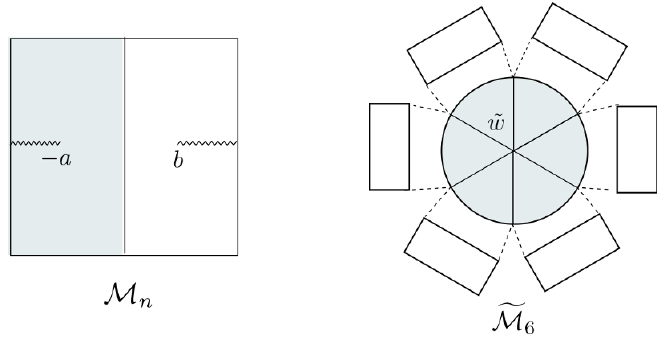
Figure 14 . Replica wormhole at zero temperature. On the right, the disk is glued to n copies of the half-plane, as indicated by the dashed